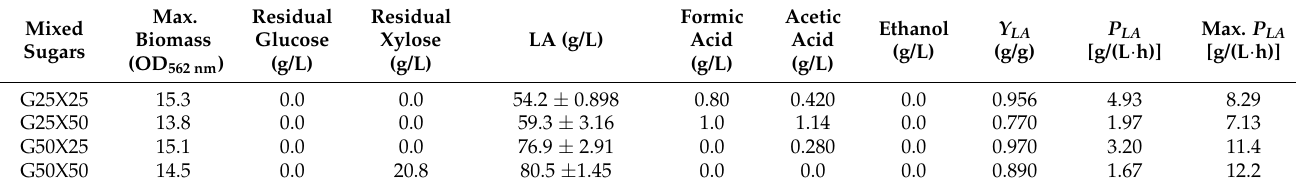
Table 3. Effect of different ratios of glucose/xylose mixtures on sugar utilization and lactic acid fermentation efficiency by B. coagulans Azu-10. Max. Mixed Sugars